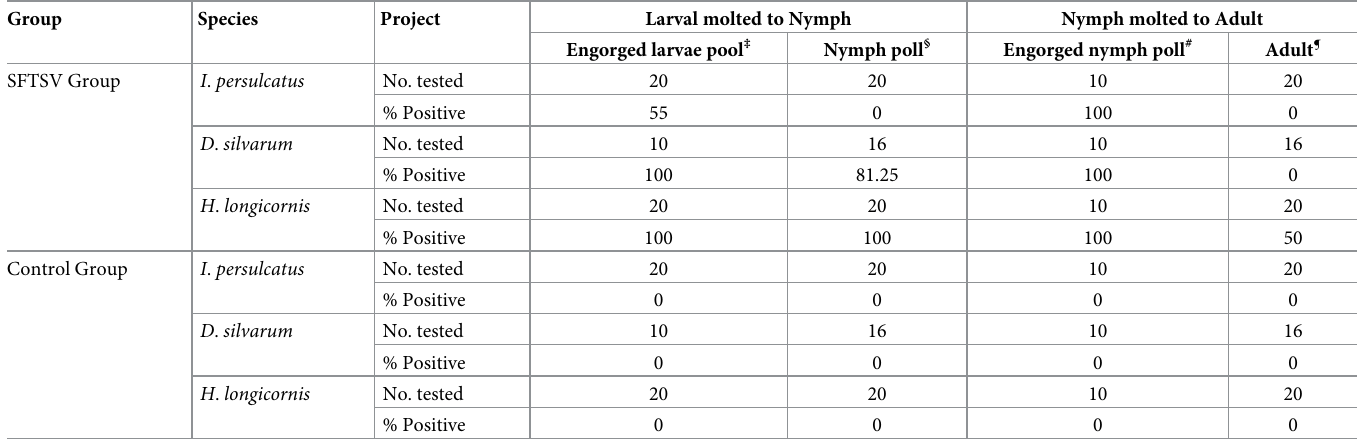
Table 2. Detection of SFTSV for three tick species in the transstadial transmission.